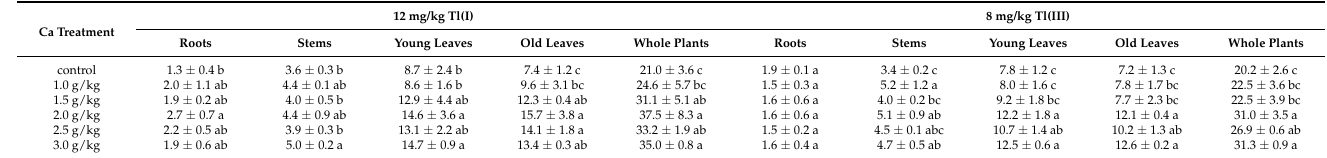
Table 3. Dry weight of the roots, stems, young leaves, old leaves, and whole plants of a single plant with 12 mg/kg Tl(I) or 8 mg/kg Tl(III) and various Ca-spike treatments (mean ± sd, n = 3, g).